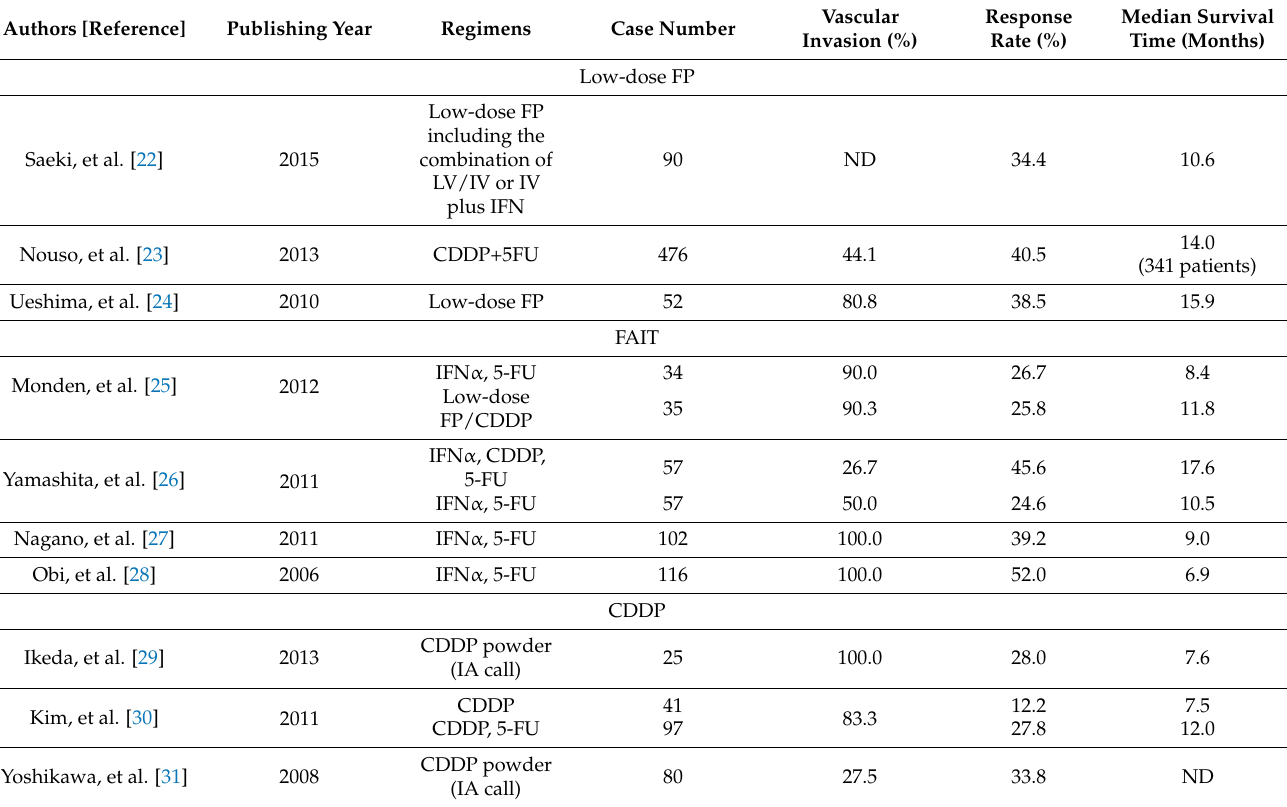
Table 1. Regimens of hepatic arterial infusion